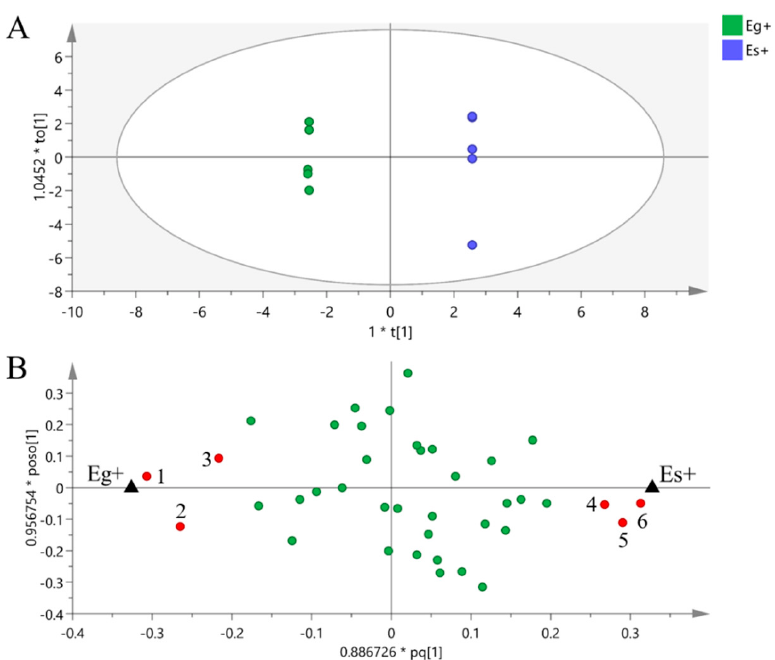
Figure 5. OPLS-DA of the metabolic profiles of Achnatherum sibiricum infected with E. gansuensis (Eg+) and E. sibirica (Es+). OPLS-DA: 1 + 4 + 0 latent variables, with R 2 X = 0.645, R 2 Y = 1.000, Q 2 = 0.840. The ellipse in score plot ( A ) defines the 95% Hotelling’s T2 confidence region. Symbols in the loading plot ( B ) refer to compounds in metabolic profiles, and the red symbols refer to differential metabolites screened between Eg+ and Es+ plant (VIP > 1, p < 0.05), (1) ribonic acid, (2) inositol, (3) β -gentiobiose, (4) tyrosine, (5) α -linolenic acid and (6) maltose, and the green symbols refer to metabolites with no significant difference.